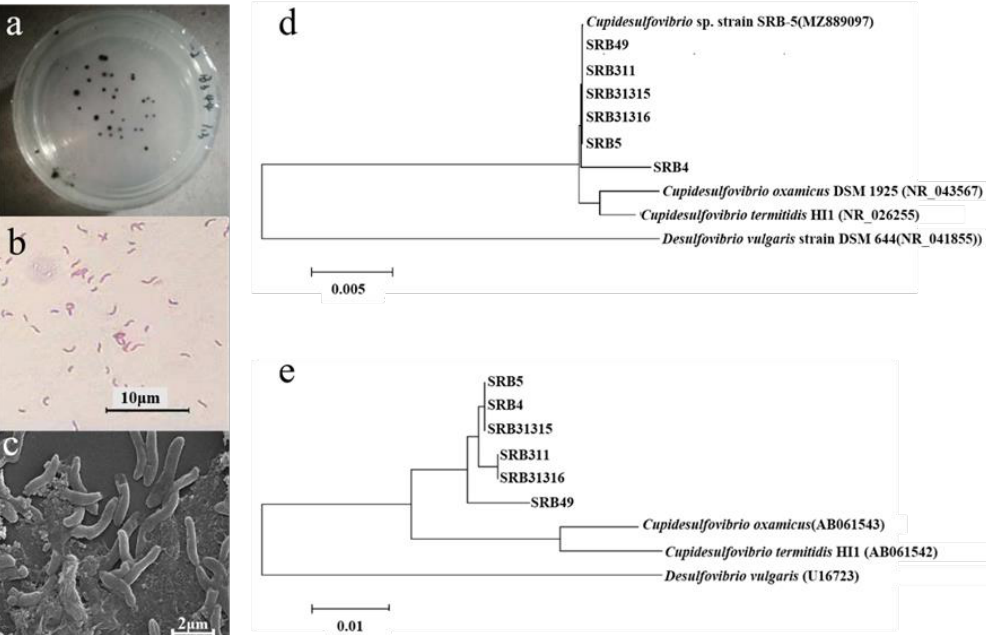
Figure 2. Morphology of SRB isolates on the plate ( a ), under optical microscope ( b ), and scanning electron microscopes ( c ). Phylogenetic tree of all SRB strains based on 1.4 Kb of 16S rRNA gene ( d ) and 300 bp of dsrB gene ( e ) sequence